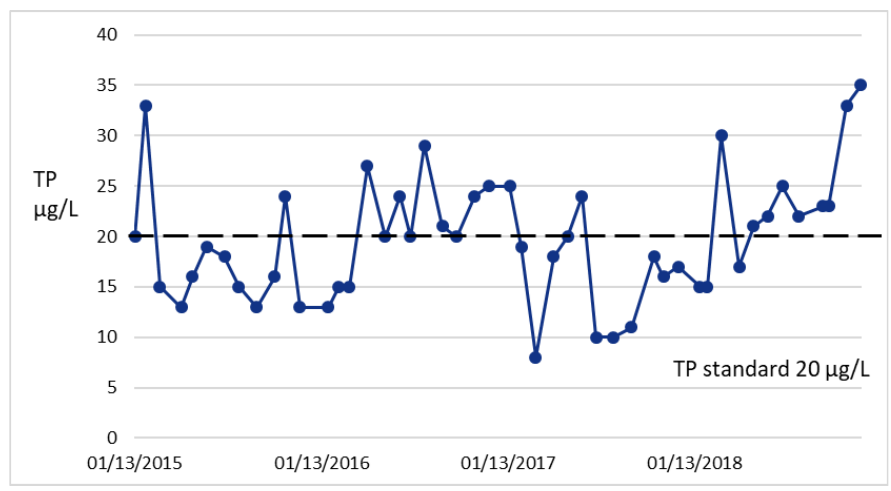
Figure 2. Total phosphorous (TP) concentration of the Jinggualiao stream from 2015 to 2018.